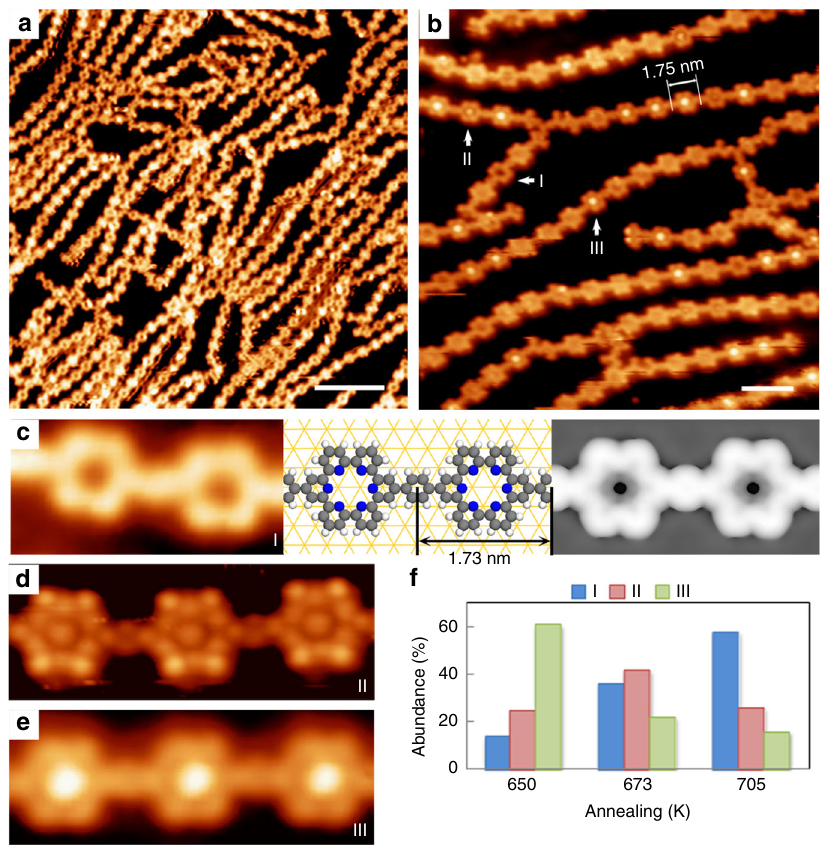
Fig. 6 SPy- p -Ph nanoribbons formed after annealing at 578-705K. a STM overview of a sample annealed at 705K. b Close-up inspection of the nanoribbons. The measured periodicity of the chain is 1.75 ± 0.05 nm. Labels I, II and III denote the three modes for the SPy macrocycles. c High-resolution STM image (left), DFT-optimized structure (middle) and the simulated STM topograph (right, U = − 0.5 V) of the I-mode SPy. d , e High-resolution STM images of the II and III-mode. f The dependence of the abundance of I, II and III-mode SPy units on the annealing temperatures (650 K, 673 K and 705 K). Scale bars: ( a ) 10 nm; ( b ) 3 nm. Data acquisition conditions: ( a ) − 0.8 V, 0.2 nA, 105 K; ( b , c and e ) − 0.5 V, 0.2 nA, 133 K; ( d ) − 1.5 V, 0.3 nA, 293